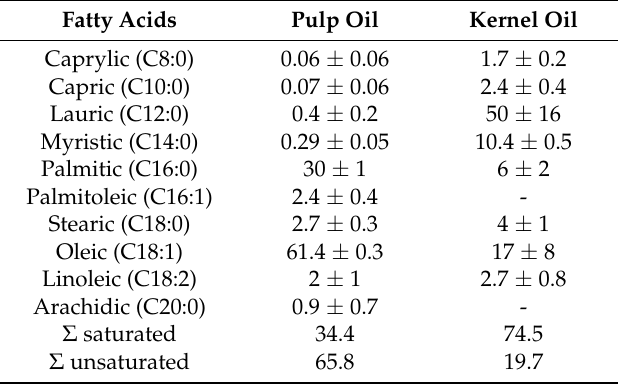
Table 1. Fatty acid composition (% of total lipid) in A. aculeata pulp and kernel